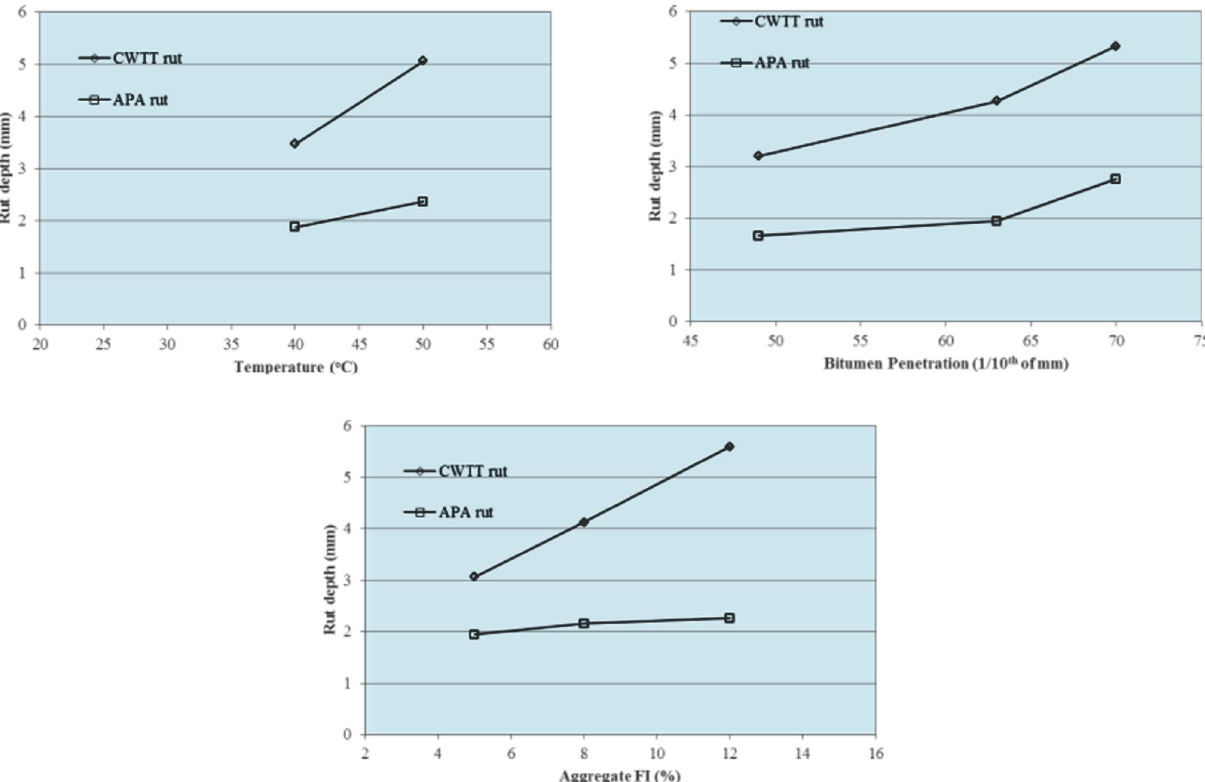
FIG. 7. MARGINAL MEAN PLOTS FOR RUT DEPTH IN CWTT AND APA